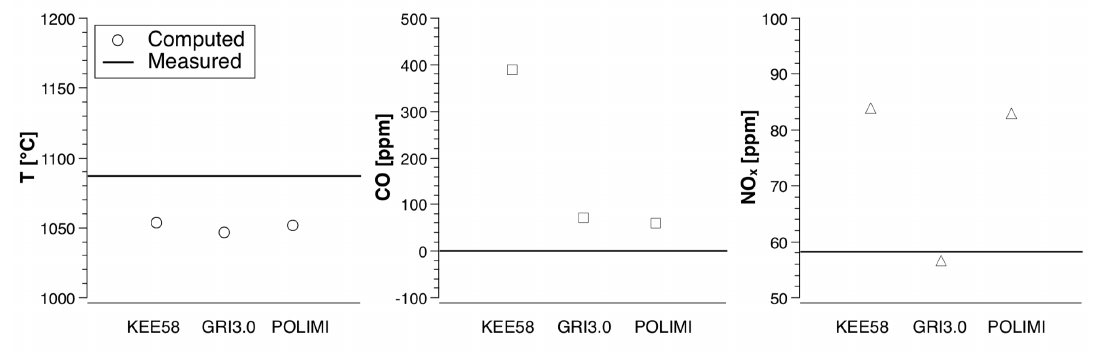
Figure 23. Comparison between the exhaust gases temperature ( ◦ C), the CO (ppm), and NO x (ppm) measured and the one predicted with different kinetic schemes. λ = 2.55. Air inlet temperature 700 ◦